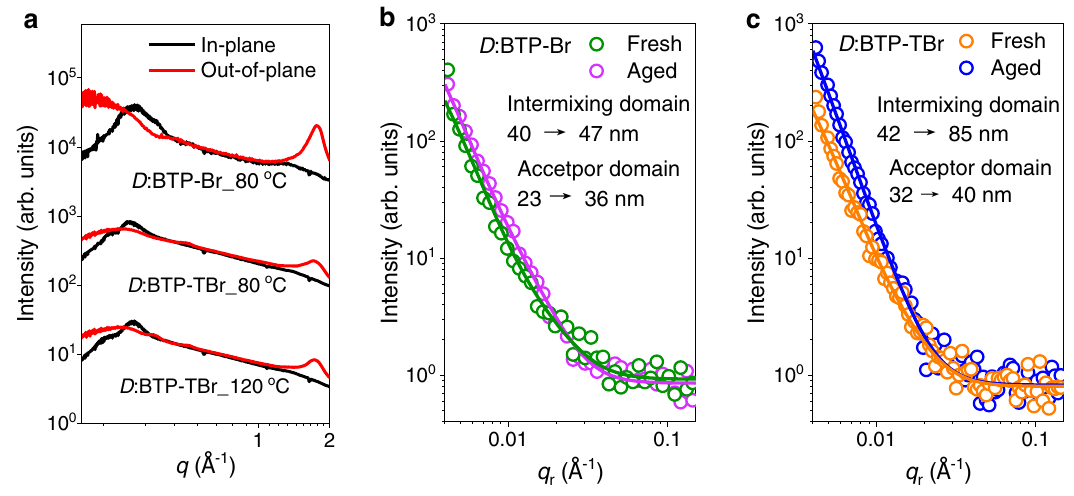
Fig. 5 | Molecular packing and morphology evolution upon thermal aging. Averaged curves of GIWAXS for blend fi lms based on PTzBI- d F ( D ) and different acceptors ( a ). In-plane intensity pro fi les of GISAXS for fresh and aged blend fi lms